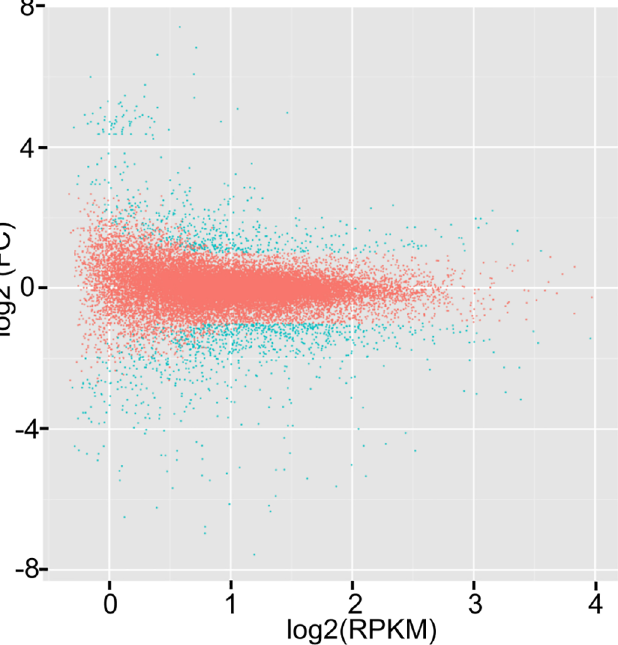
Fig 3. Differentially expressedgenes (DEGs) between PamCd and PamNor gene pools with and without cadmium treatment. The red color represents non-DEGs, and the blue represents DEGs. The x- axis is log2 RPKM and the y-axis stand for log2 of estimated fold change.